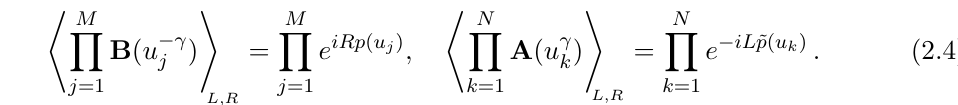
`` Figure 1 . Particles wrapping the space and the time circles. On the left the wrapping particles are depicted as closed paths winding around the two main circles of the torus. On the right the wrapping particles are represented by vertical and horizontal lines on a periodic rectangle. The topology requires that each pair of a space and a time wrapping particles scatter =